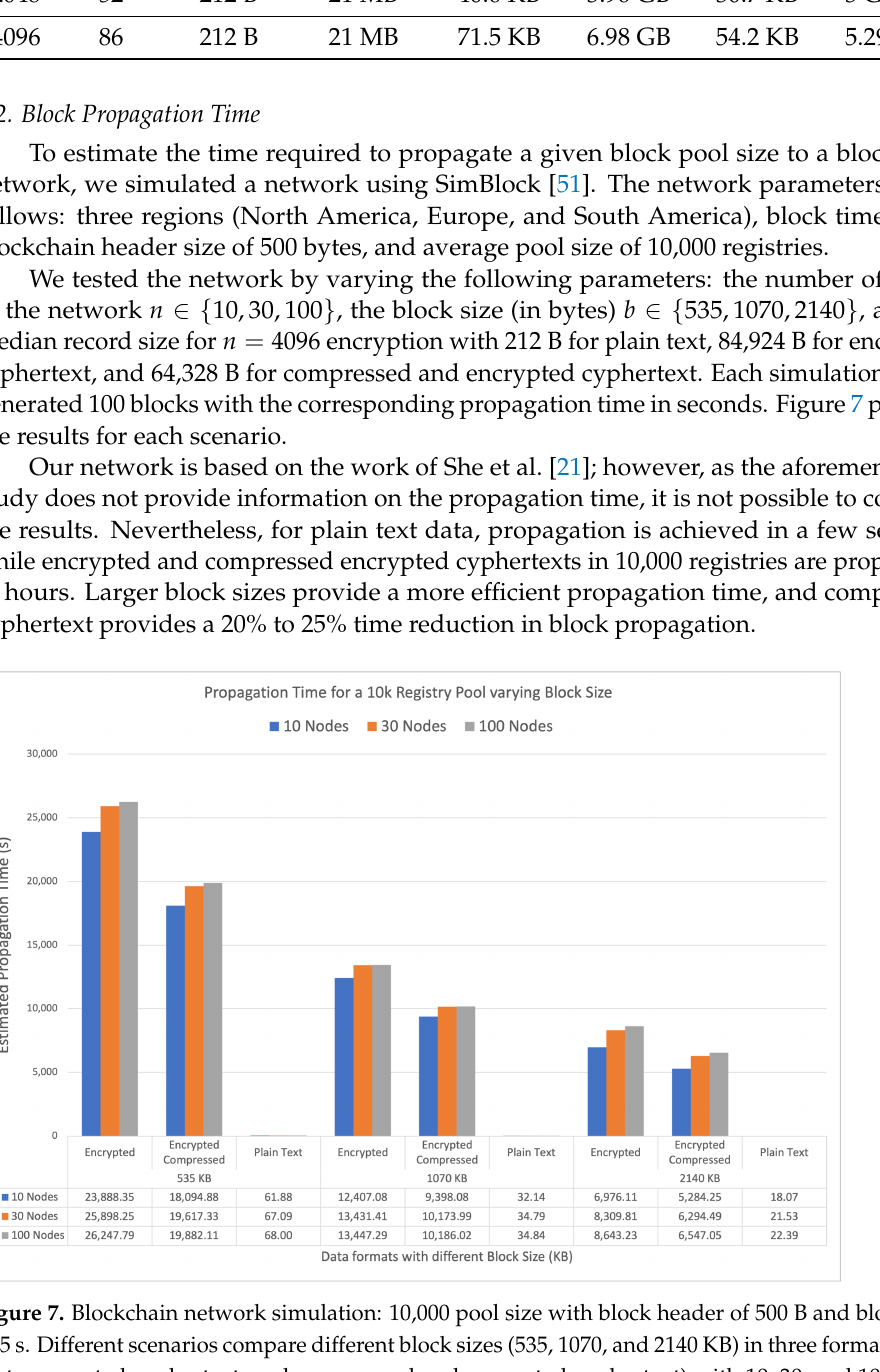
Table 7. Storage consumption: As the ( n , q ) pair increases, the cyphertext string size (KB) also increases. Each column S corresponds to the average size of the registry in plain, encrypted, and com- pressed formats, while each column T refers to the total storage amount for a set of 100,000 registries. Plain Text Encrypted Compressed S plain T plain